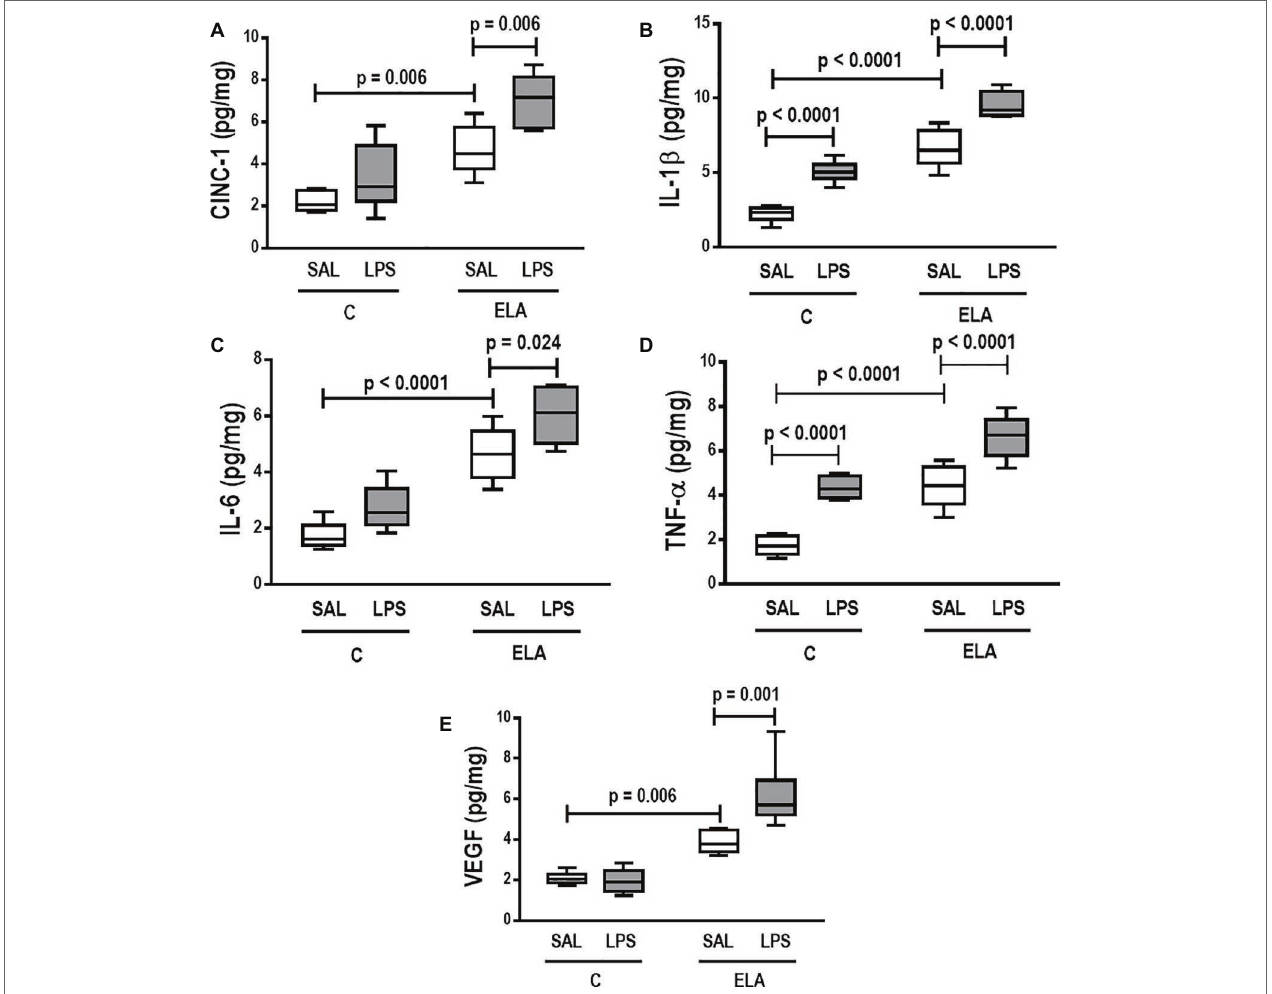
FIGURE 4 | Levels of (A) keratinocyte-derived chemokine (cytokine-induced neutrophil chemoattractant [CINC]-1, a rat analog of interleukin-8), (B) interleukin (IL)-1 β , (C) IL-6, (D) tumor necrosis factor (TNF)- α , and (E) vascular endothelial growth factor (VEGF) in lung tissue. C, control; ELA, animals treated with intratracheal instillations of elastase; SAL, saline; LPS, E. coli lipopolysaccharide. Values are median (interquartile range) of six animals in each